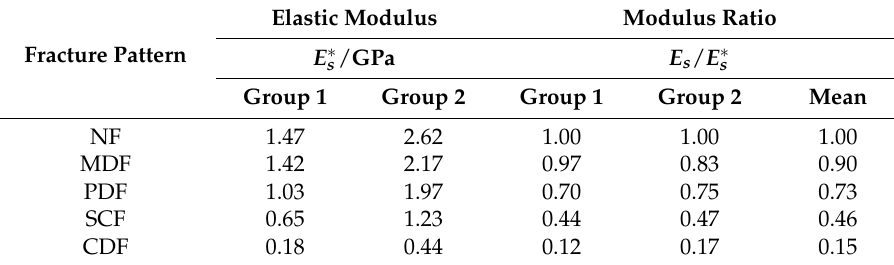
Table 3. Elastic modulus of intact and fractured coal samples.